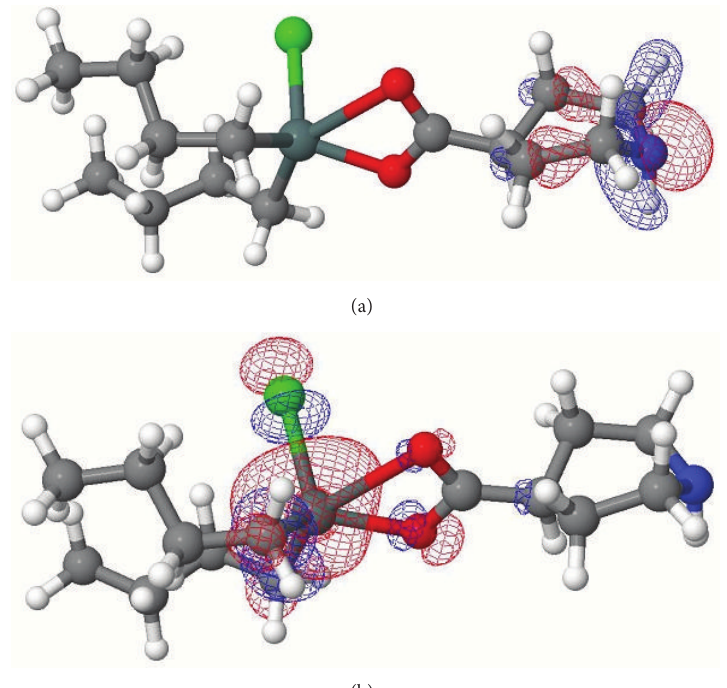
Figure 2: (a) HOMO of complex 2 ; (b) LUMO of complex 2